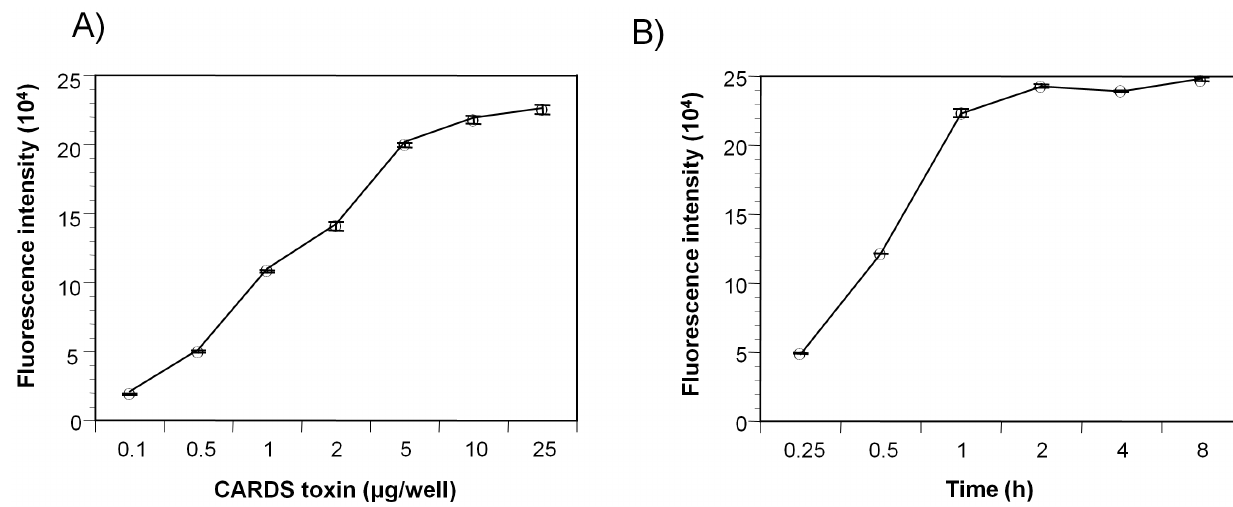
Figure 2. Binding kinetics of fluorescence labeled rCARDS toxin. ( A) rCARDS toxin binding to HeLa cells is concentration dependent. HeLa cells were treated with different concentrations (0.1 to 25 m g/well) of DyLight 649 fluorescence labeled rCARDS toxin for 1 h at 4 u C. Cell monolayers were thoroughly washed with cold PBS buffer, and toxin binding was measured using fluorometer. (B) rCARDS toxin binding to HeLa cells is time dependent. HeLa cells were treated with 10 m g of DyLight 649 fluorescence-labeled rCARDS toxin for 15 min to 8 h at 4 u C, and binding was analyzed as described above.